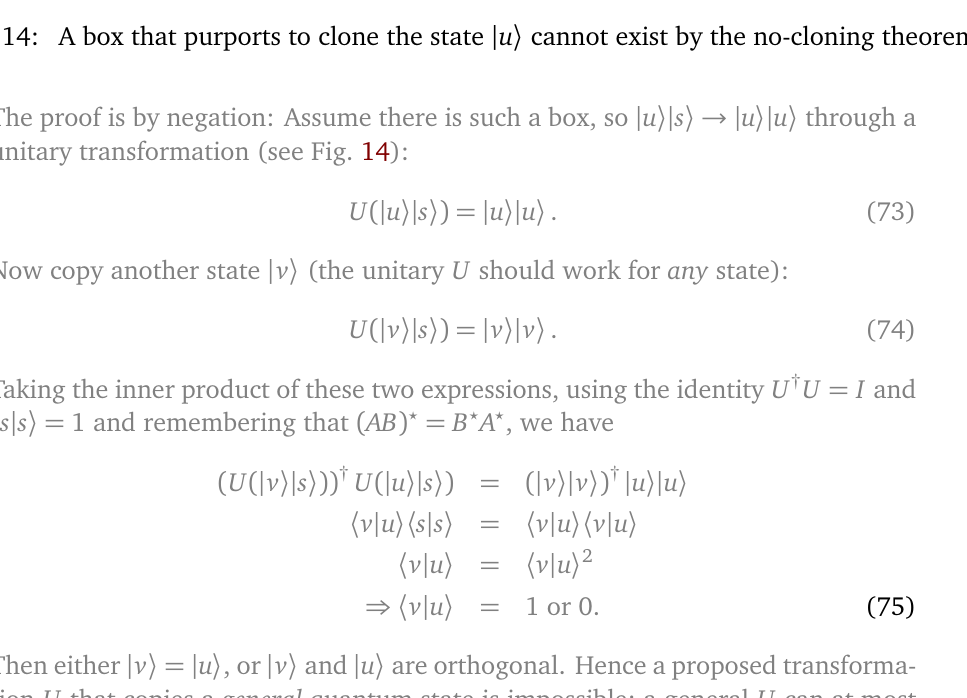
Figure 14: A box that purports to clone the state | u 〉 cannot exist by the no-cloning theorem.